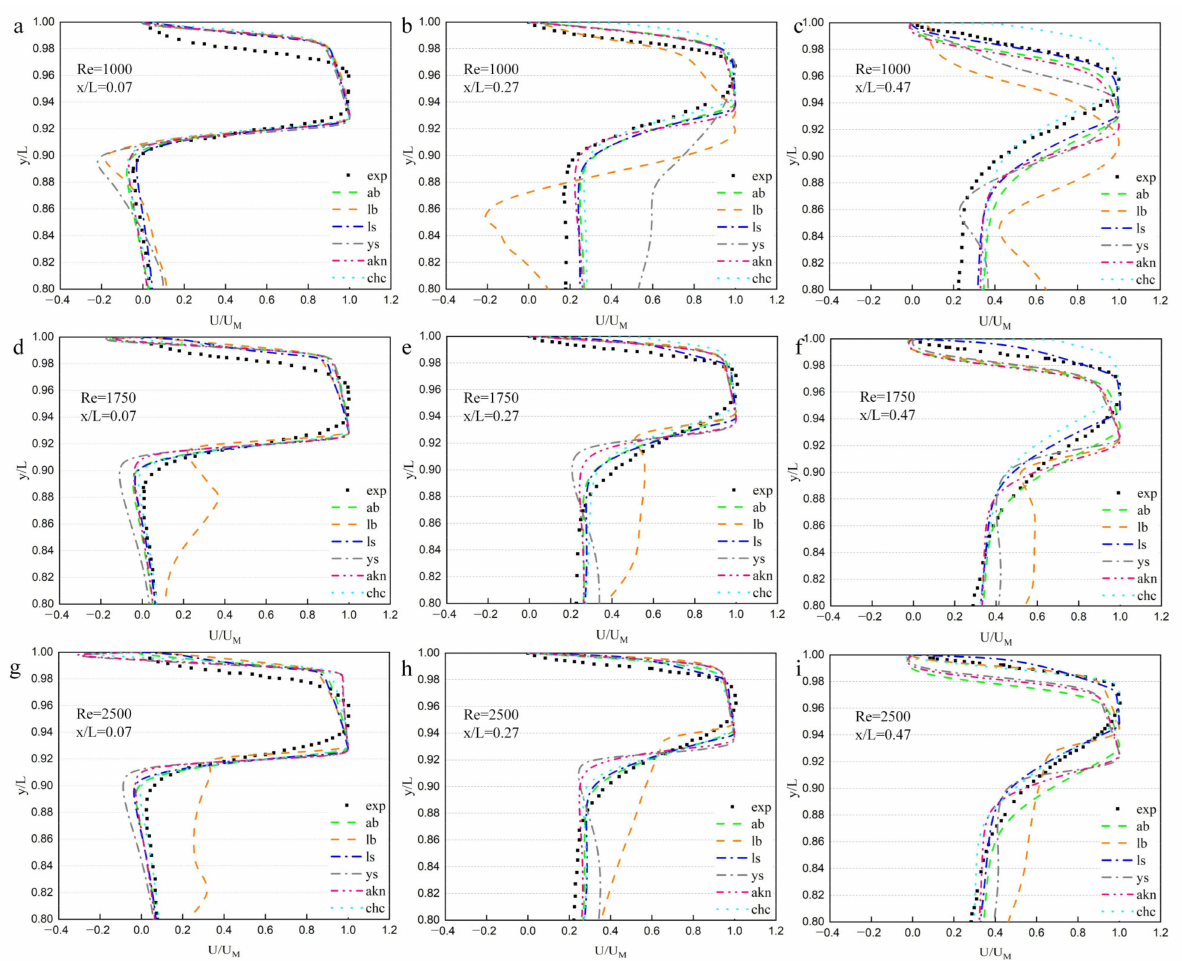
Figure 4. Comparison of mean dimensionless x-velocity profiles measured by PIV and modeled by six low-Reynolds number k- ε models. ( a ) Re = 1000, x/L = 0.07; ( b ) Re = 1000, x/L = 0.27; ( c ) Re = 1000, x/L = 0.47; ( d ) Re = 1750, x/L = 0.07; ( e ) Re = 1750, x/L = 0.27; ( f ) Re = 1750, x/L = 0.47; ( g ) Re = 2500, x/L = 0.07; ( h ) Re = 2500, x/L = 0.27; ( i ) Re = 2500, x/L =